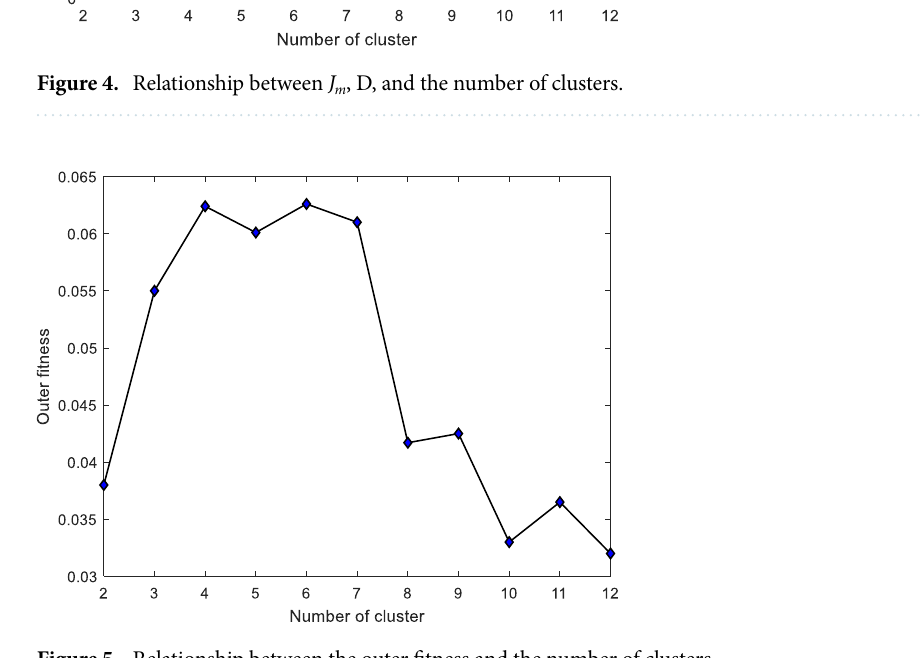
Figure 5. Relationship between the outer fitness and the number of clusters.